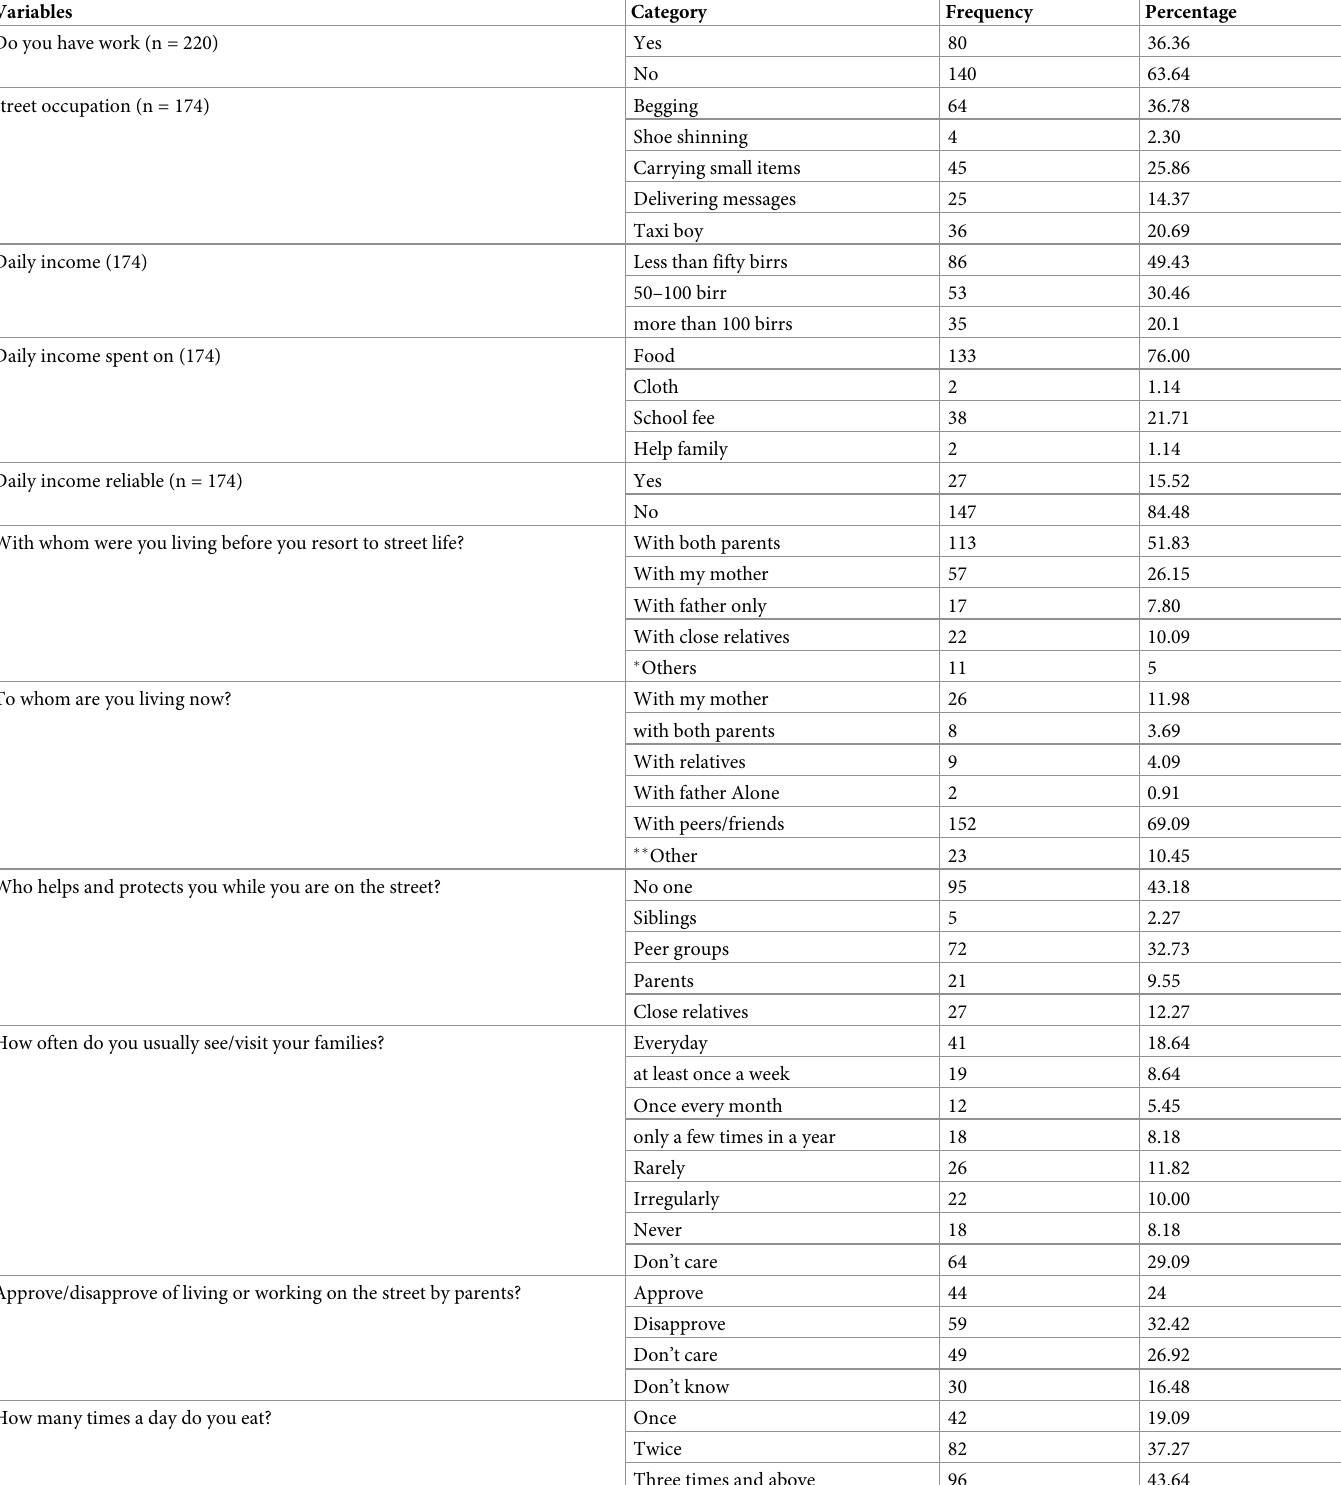
Table 4. Life condition or circumstances of streets in Harar, Eastern Ethiopia,